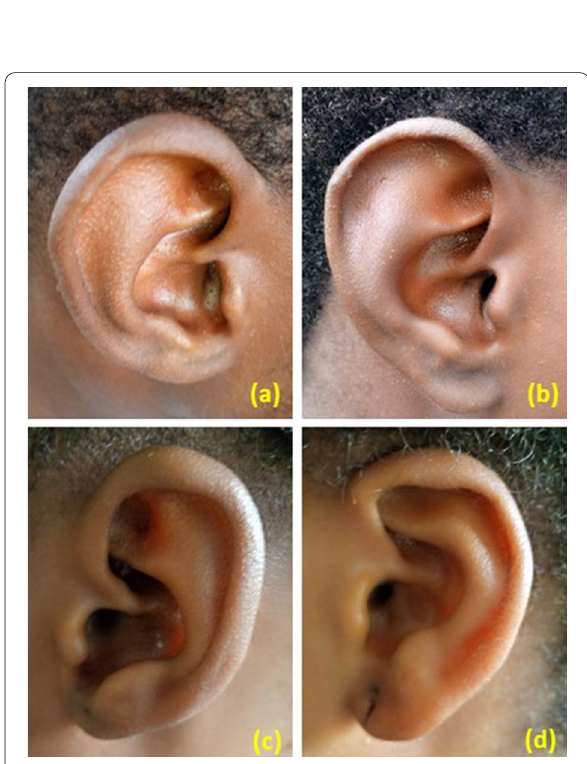
Fig. 3 Photographs of the shape of the ear: round ( a ), oval ( b ), rectangular ( c ), triangular ( d